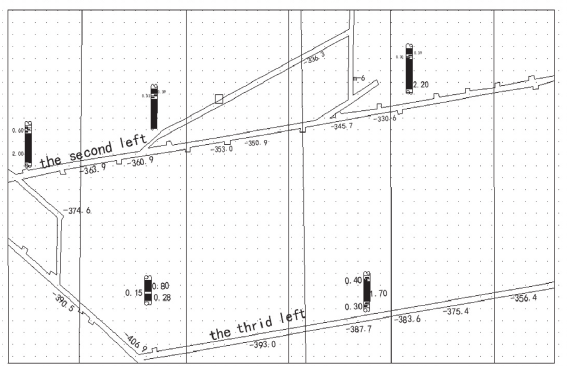
Figure 1: Roadway layout of the left third working face in the No. 8 mining area of 49 coal seams in Xinxing Coal